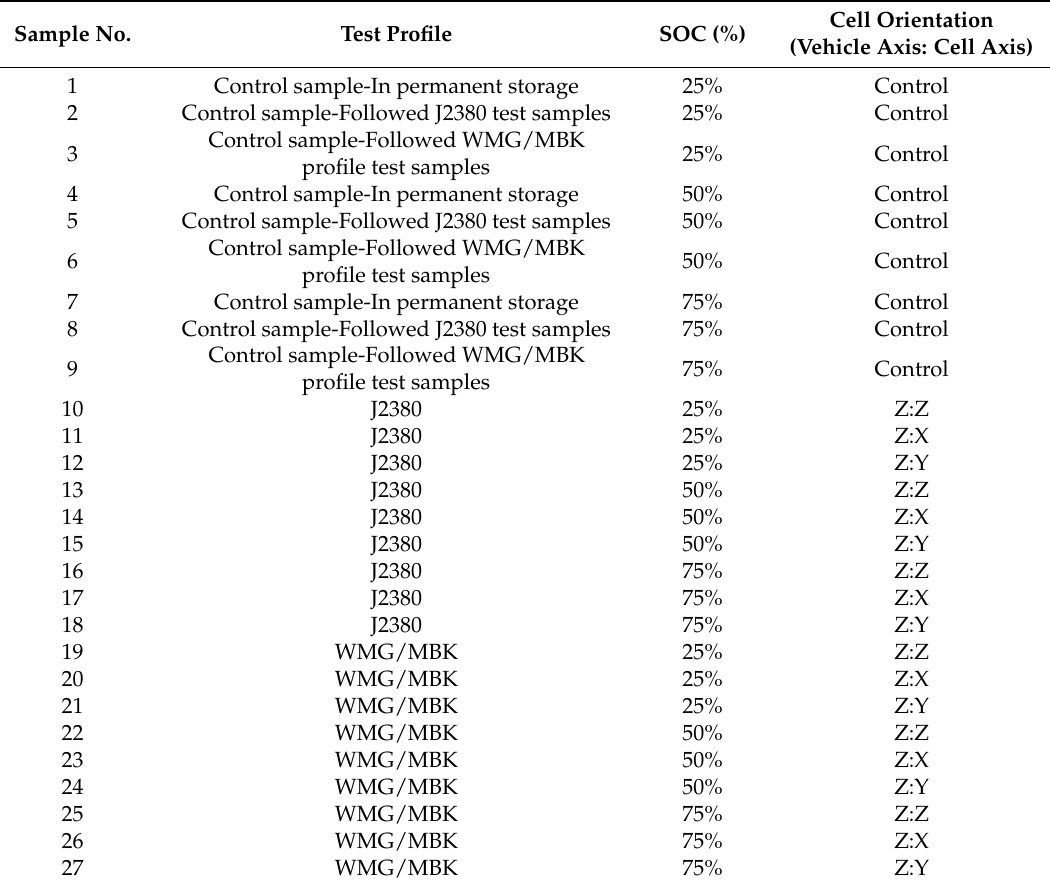
Table 1. Test sample